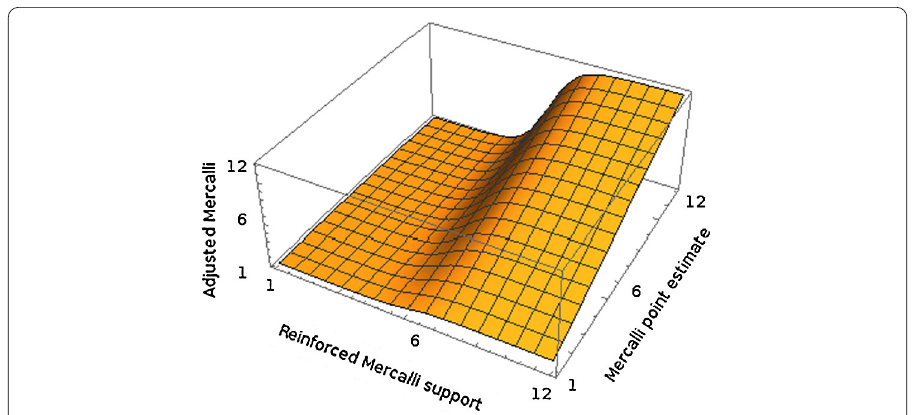
Figure 4 The adjusted Mercalli estimate surface. The adjusted Mercalli estimate surface combines the effect of Mercalli point estimates and support in a collection of sigmoids stretched by intensity. The level of activation is a parameter of our intensity scale. For instance, this surface shows an activation level fixed at Mercalli 6, driving the method towards detecting high energy events